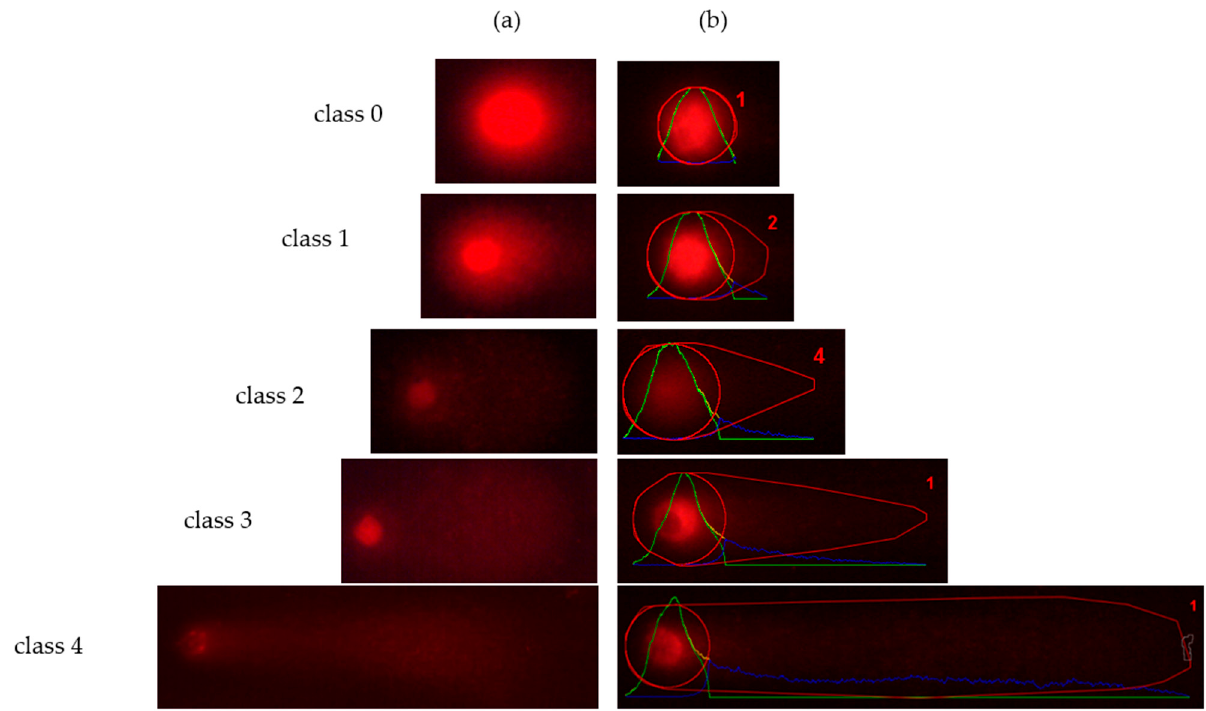
Figure 4. Representative images of the range of different comet categories. ( a ) Photographs obtained in our comet assay for each treatment. ( b ) Tail Moment (TM) parameter analysed using OpenComet plugging for ImageJ Software. Class 0: TM < 1 (negative control—no damage); class 1: TM = 1–5 (shot tails—slightly damaged); class 2: TM = 5–10 (medium damaged); class 3: TM = 10–20 (hedgehog pattern—highly damaged); class 4: TM > 20 (completely damaged—apoptosis).